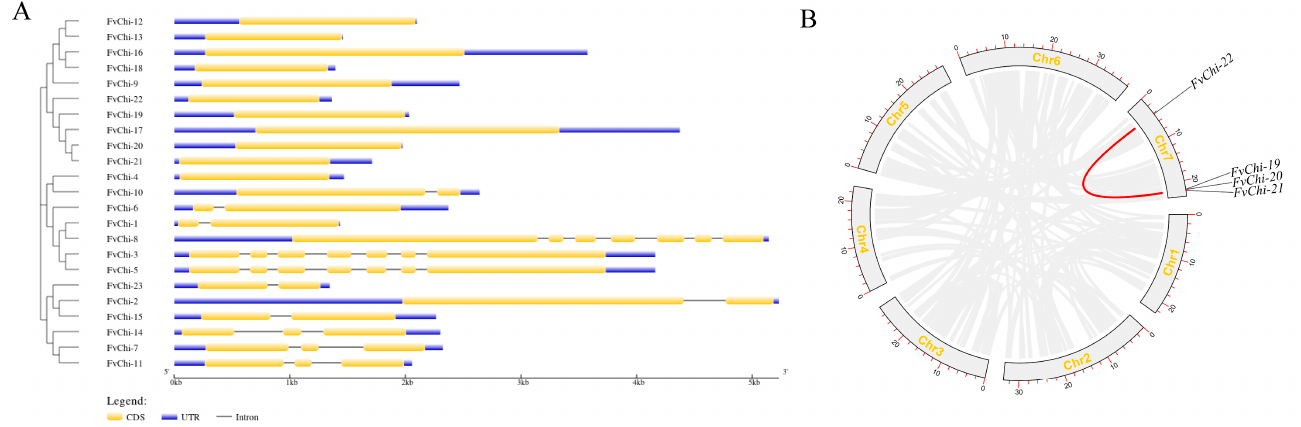
Figure 4. Exon–intron structure and collinearity analysis of FvChi genes. ( A ) Exon–intron structure of FvChi genes. UTRs are shown as blue boxes, exons as yellow boxes, and introns as black lines. ( B ) Collinearity analysis of FvChi genes. The syntenic relationships of FvChi genes are connected by a red line.